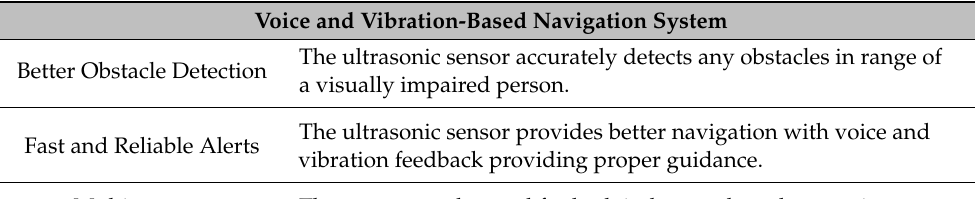
Table 8. Properties of Voice and Vibration Navigation